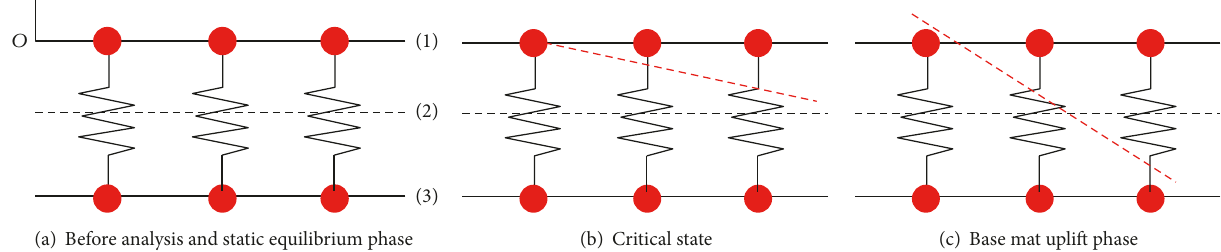
Figure 4: Schematic diagram of the working state of spring element. (1) base mat plane, (2) static equilibrium plane, and (3) copied plane (for the establishment of spring element).